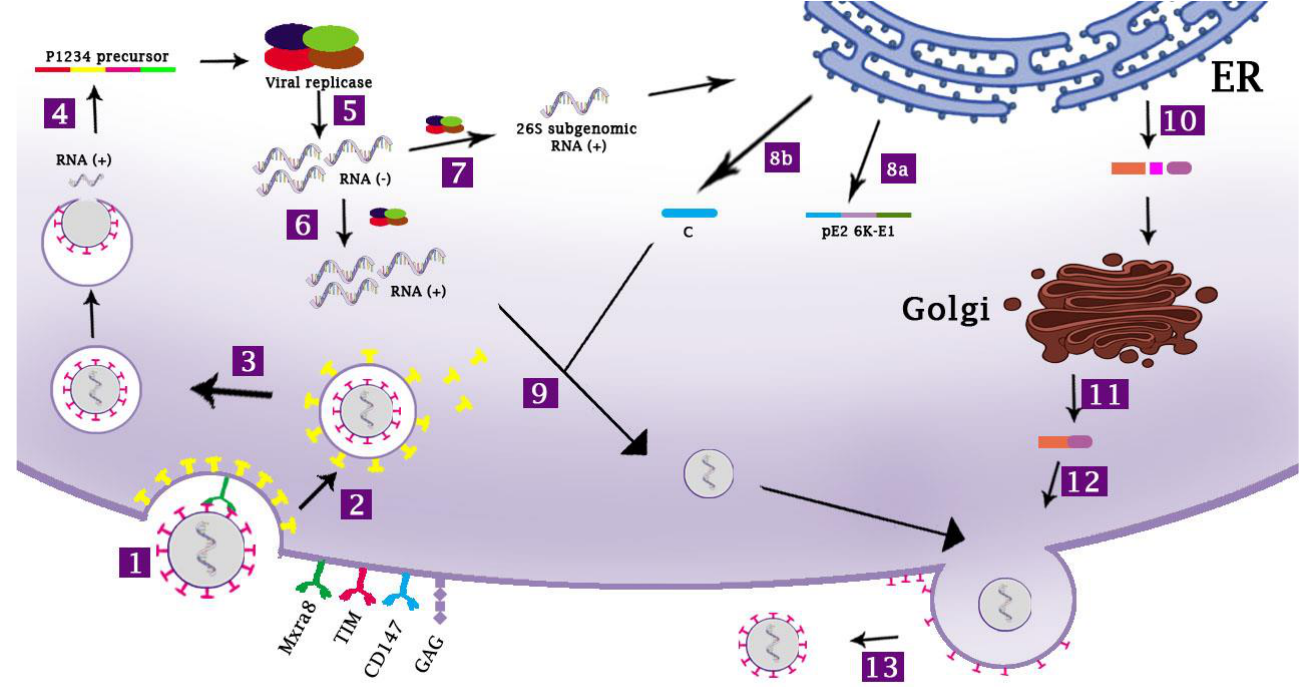
Figure 2. The life cycle of CHIKV infection. There are several potential receptors for CHIKV, including Mxra8, CD147, GAGs, and TIM [1] . CHIKV enters the target cells via clathrin-mediated endocytosis pathway [2] . Other entry pathways, such as micropinocytosis, are not depicted. Upon formation of the early endosome, clathrin molecules dissociate from the endocytic vesicle [3] . The pH acidification of endosome (endocytic vesicles) triggers the fusion of the endosomal membrane with the viral membranes (the E1 protein), releasing the genomic RNA, followed by an immediate translation of the non-structural polyproteins (P1234 precursor) by the ribosome [4] . The P1234 pol- yprotein is then cleaved by the nsP2, releasing the individual non-structural proteins, to form the viral replicase complex. The complex mediates the synthesis of the negative-strand RNA [5] that serves as templates for the synthesis of new positive-strand RNA [6] as well as for the synthesis of 26S subgenomic RNA [7]. The synthesis of negative-strand RNA intermediate, genomic, and sub- genomic RNA occurs in the specialized replication compartments termed spherules (not depicted).